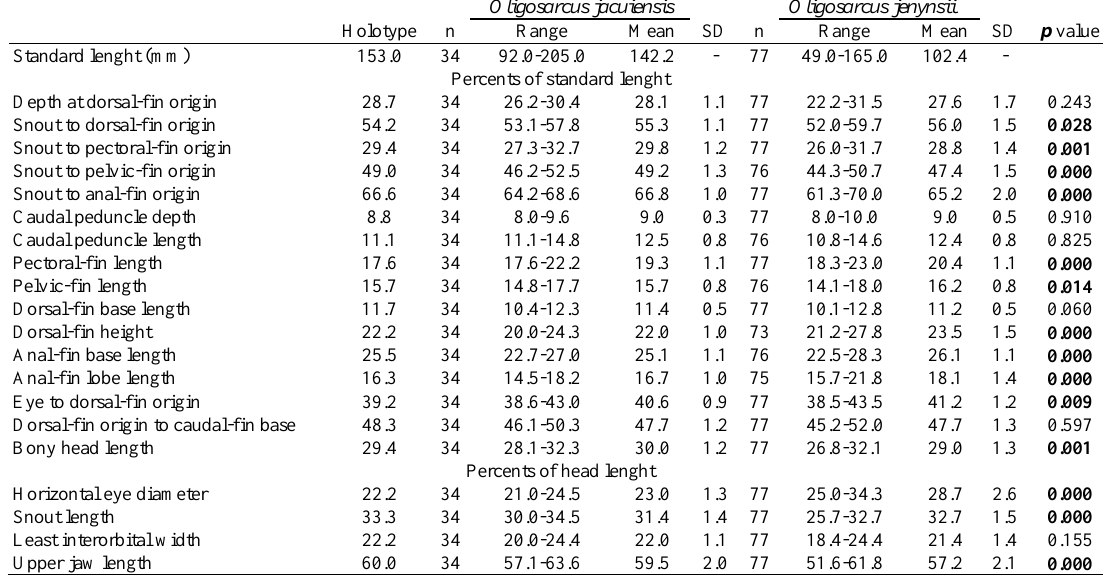
Table 1. Morphometrics of Oligosarcus jacuiensis , new species (MCP 28980, holotype; MCP 18876, 26979, 37930, 44405; and MZUSP 104604, paratypes). Data of O . jenynsii (see comparative material examined) introduced for